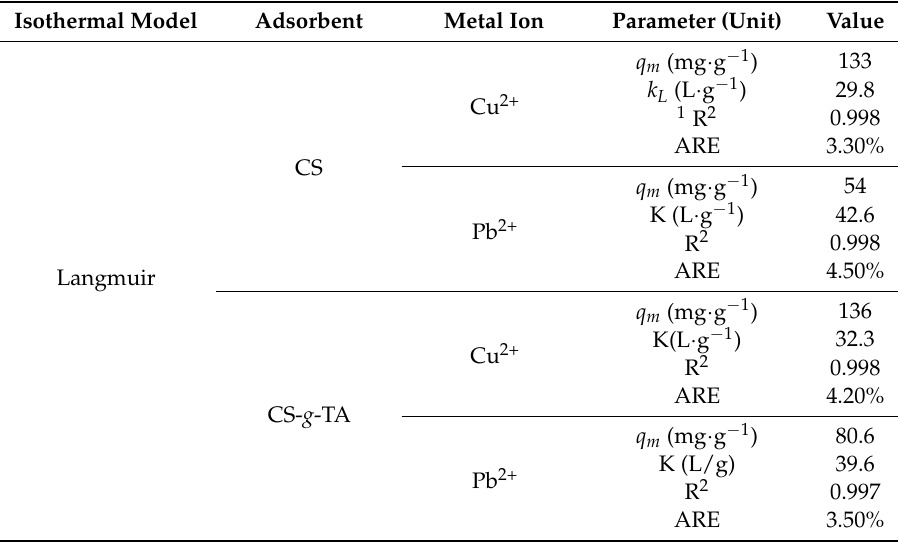
Table 2. Theoretical Isothermal fitting experimental